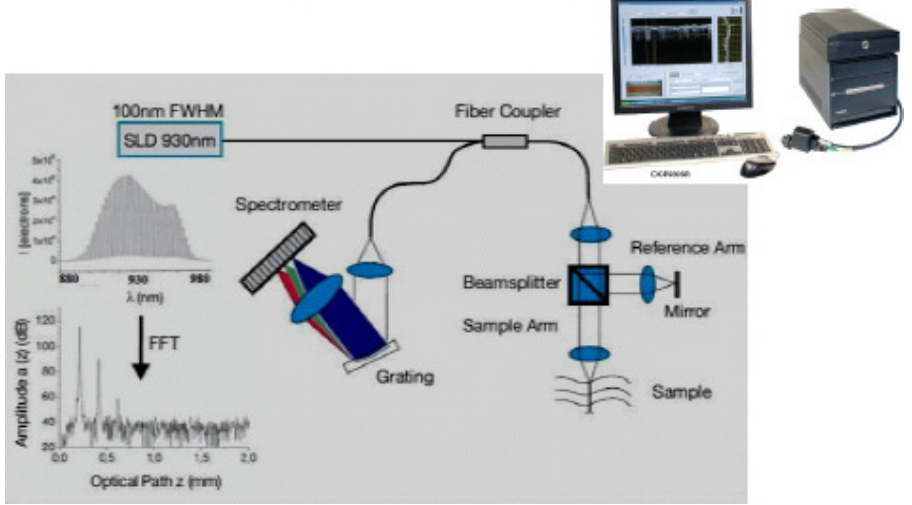
Fig. 1. Thorlabs spectral Radar OCT with a Handheld Probe